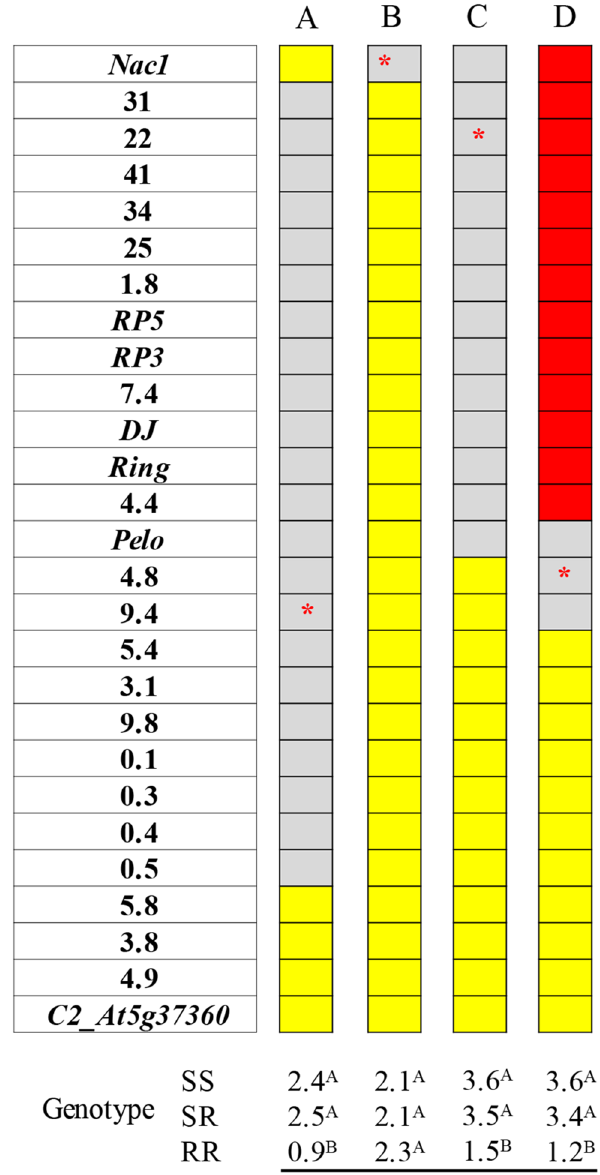
Fig 1. Association between DNA markers spanning the ty-5 locus and disease severity in representative segregating populations. In the ruler presented to the left of each analysis: yellow-shaded markers are homozygous for the allele originated from the susceptible line M-82 (SS), red-shaded markers are homozygous for the allele originated from the resistant line TY172 (RR) and gray-shaded markers are heterozygous (SR); the analysis of variance presented at the bottom of each population was carried out with different markers: the marker in red asterisks is the one that was used as an independent variable in each analysis; different superscript letters above means indicate statistically significant difference, P < 0.05, between genotypes for each population separately; A-D: four different representative segregating populations; DSI (disease severity index) was determined at 28 DPI (days post inoculation) and at 42 DPI, the DSI values presented is an average of both